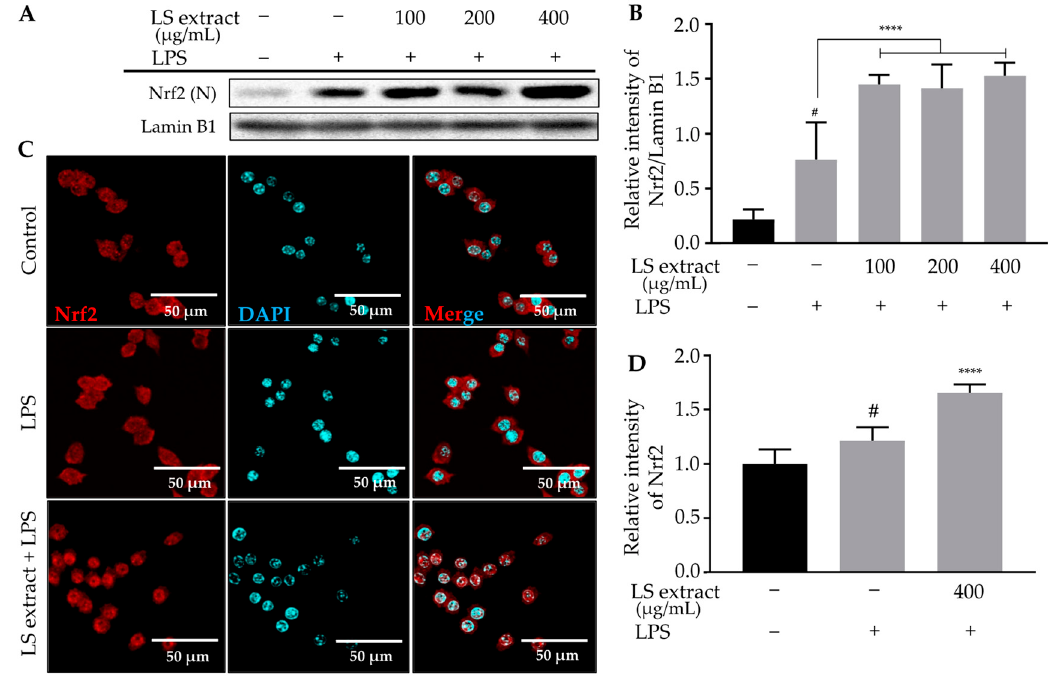
Figure 9. Effects of LS leaf extract on Nrf2 translocation in LPS-stimulated RAW 264.7 cells. Cells were pretreated with LS leaf extract for 24 h, followed by LPS (1 µ g / mL) stimulation or 18 h. Nuclear (N) Nrf2 was analyzed by Western blot ( n = 3) ( A ). Lamin B1 was used as a nuclear loading control. The relative band intensity of Nrf2 (N) compared to lamin B1 was quantified using Image J ( B ). The cells were treated with culture medium only (control), LPS only (1 µ g / mL), or LS leaf extract (400 µ g / mL) and LPS (1 µ g / mL), and stained with an Nrf2 antibody labeled with Alex Fluor 594 (red) and DAPI (blue). Representative images acquired by confocal fluorescence microscopy are shown in ( C ). Fluorescent intensity was analyzed using MetaMorph software ( D ) ( n = 30). Values represent the mean ± SD; scale bar, 50 µ m. Statistical significance was calculated by t -test and one-way ANOVA. # p < 0.05 vs. cells treated with media only; n. s., not significant; **** p < 0.0001 vs. cells treated with LPS